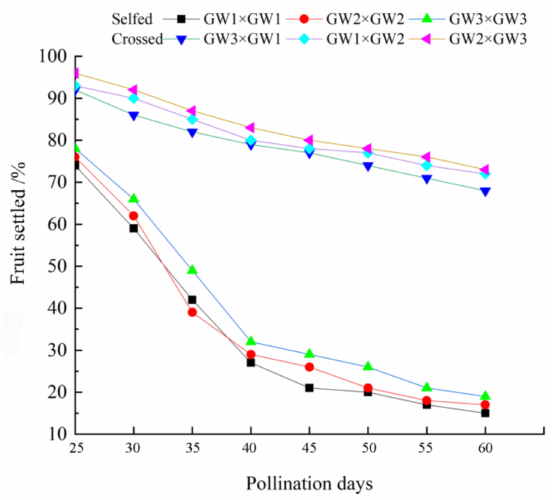
Figure 6. Dynamic changes in the early fruit setting rates after self- and cross-pollination.